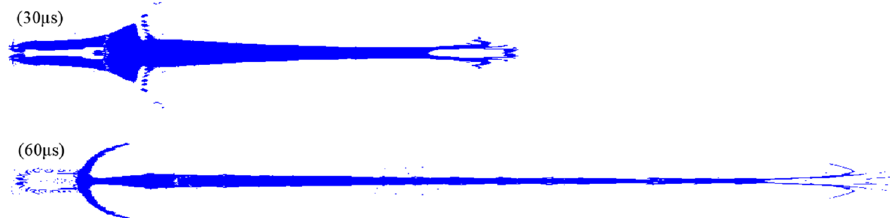
Figure 8. 2D jet morphology under the Euler algorithm.